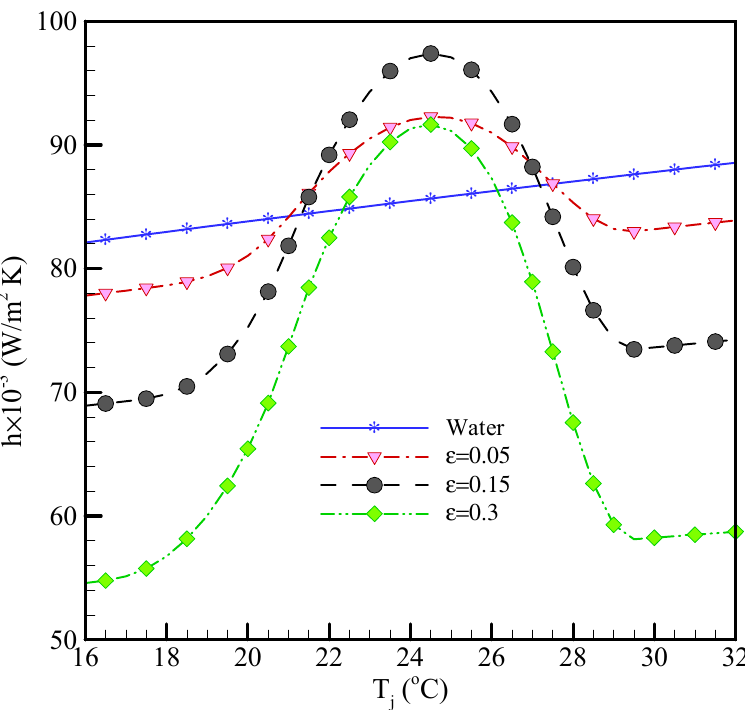
Figure 10. Heat transfer coefficient profiles as function of inlet jet temperature for water and NEPCM slurry with different particle volume fraction ( V j = 8